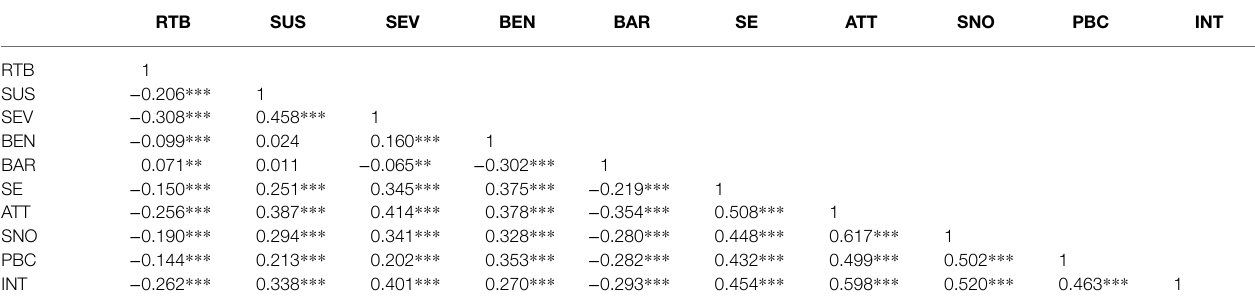
TABLE 5 | Intercorrelation matrix.